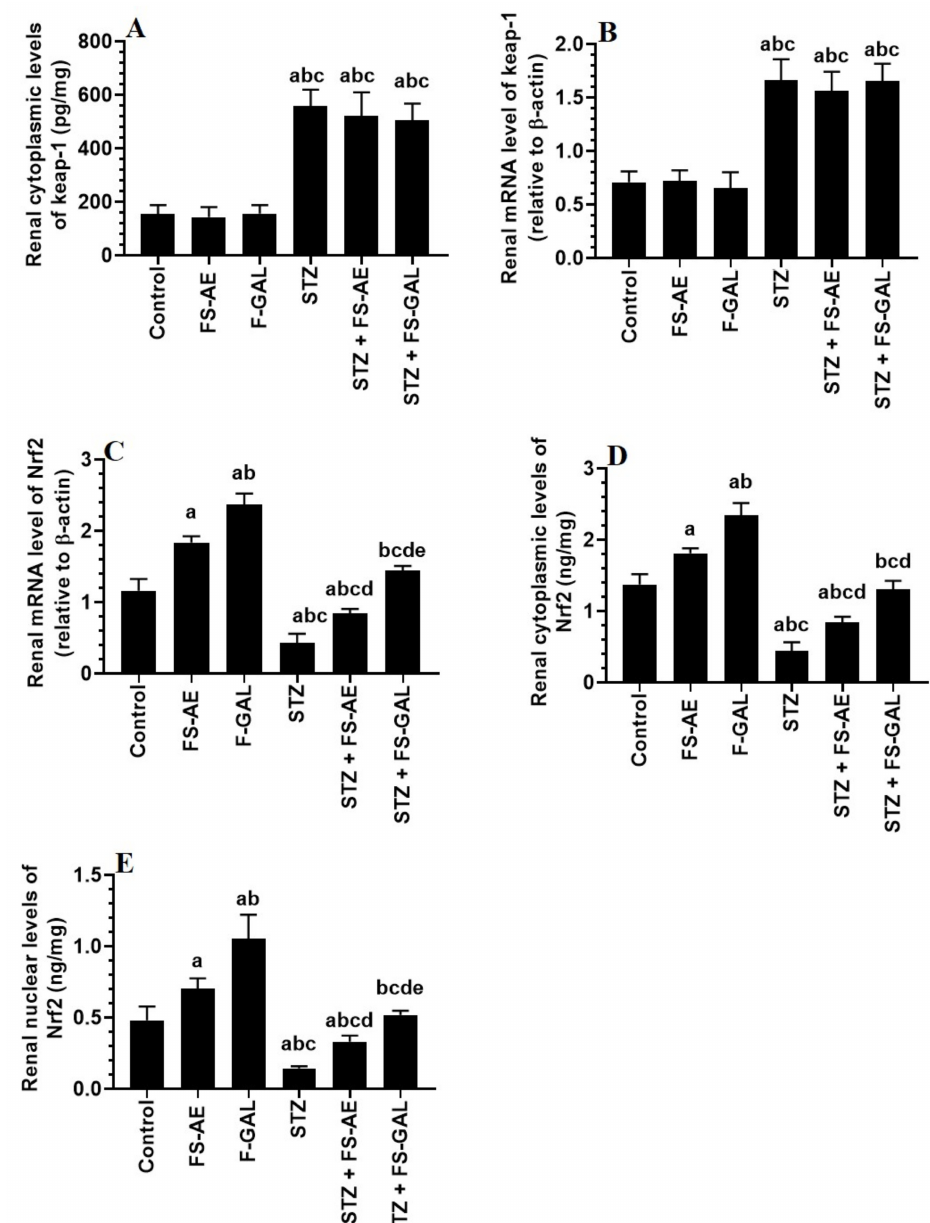
Figure 4. mRNA and cytoplasmic levels of keap-1 ( A , B ) and Nrf2 ( C , D ), as well as nuclear levels of Nrf2 ( E ) in the kidneys of all groups of rats. All values are shown as means ± SD ( n = 8/group). a : vs. control rats, b : vs. Fenugreek seed aqueous extract (FS-AE)-treated rats, c : vs. Fenugreek seeds galactomannan-treated rats. d : vs. streptozotocin (STZ)-diabetic rats, e : vs. STZ + FS-AE-treated